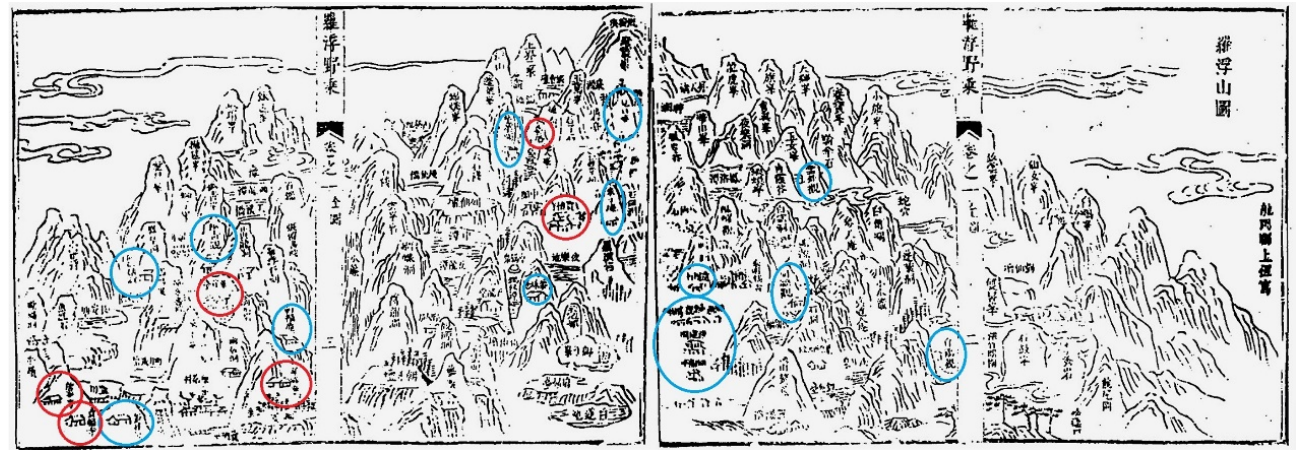
Table 3. Religious Architecture Depicted in Illustrations of Han Mingluan’s Luofu zhilue .